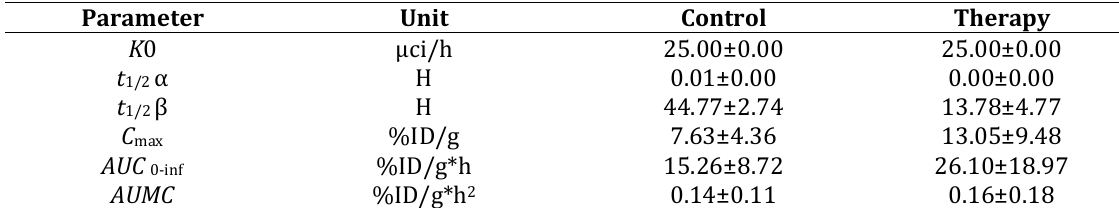
Figure 4. Ratio Target/ Non-target (T/NT) organ of [ 99m Tc]Tc-ketoconazole with the administration of ketoconazole 1 h post-injection (A) and 3 h post-injection (B) ( n =3). Data are presented as the mean ± SD from three mice with p <0.05. Table I. Pharmacokinetics study of [ 99m Tc]Tc-ketoconazole 1h post-injection between control (saline) and therapy group